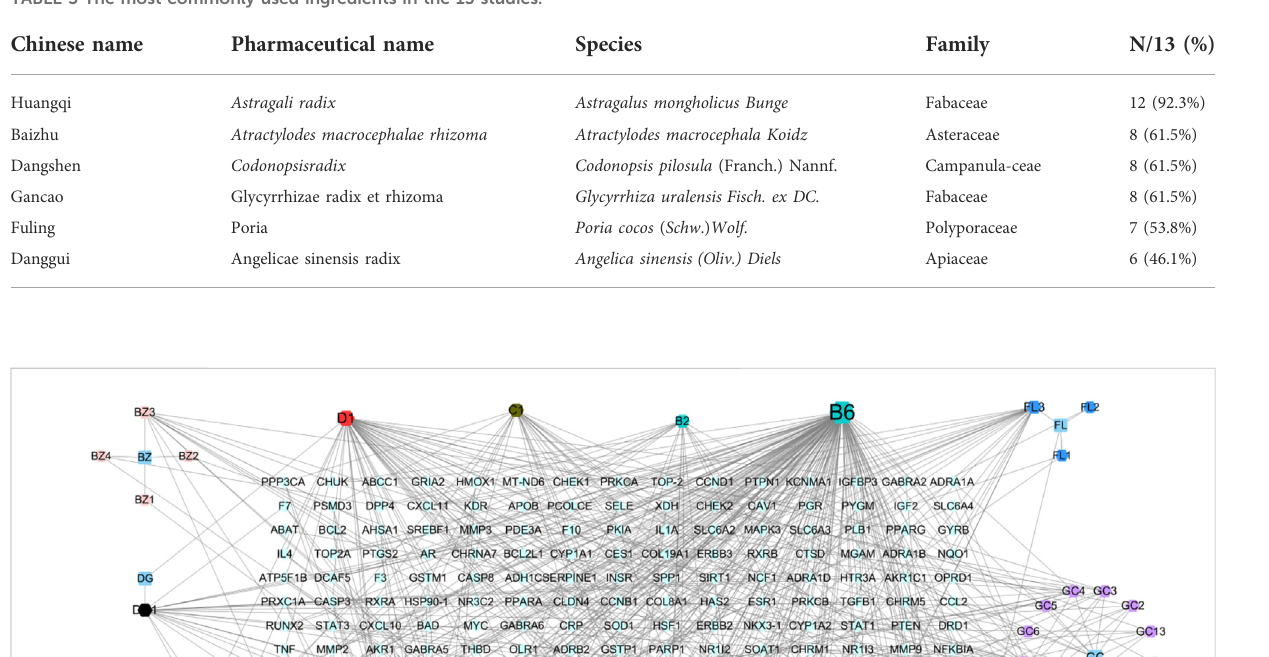
TABLE 3 The most commonly used ingredients in the 13 studies.